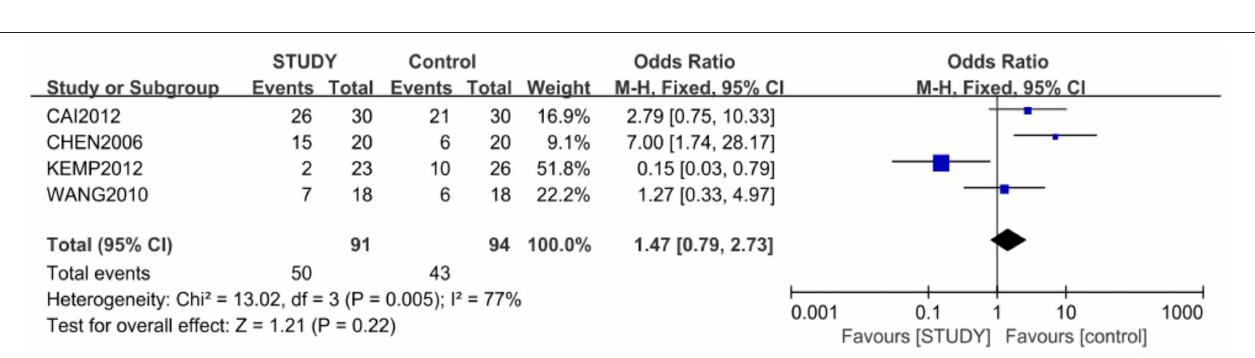
(OR = 1.05; 95% CI: 0.49 ∼ 2.25; Z = 0.13, P > 0.05,) ( Figure 4